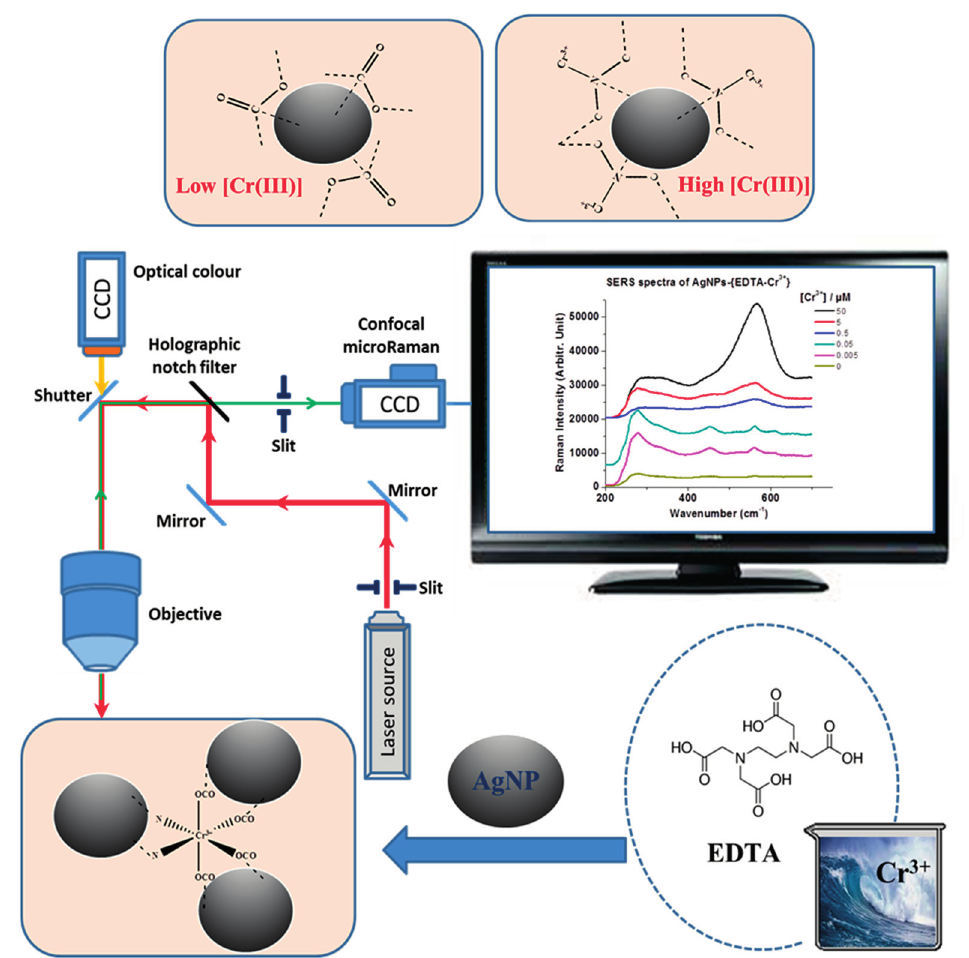
Figure 6. Schematic diagram of detection of Cr(III) using AgNPs. The carboxylic acid group of EDTA is expected to bind on AgNPs at low concentrations of Cr(III). As the Cr(III) increased, the intensified Cr(III)-N mode could be monitored by confocal